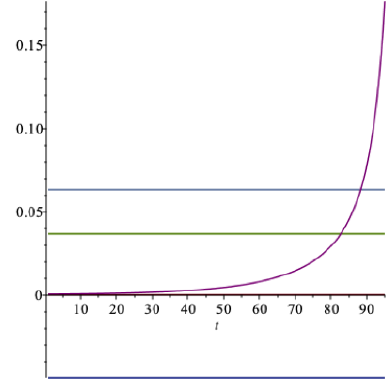
Figure 10. Spending rate when k is zero; γ > ρ , 1/ ρ =